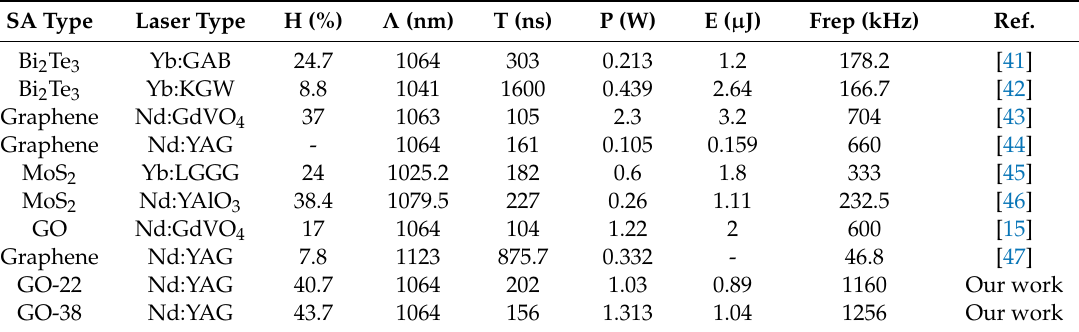
Figure 8. ( a ) Average output power of CW and QS as a function of the pump power; ( b ) repetition rates and pulse durations as a function of the pump power. Single pulse energy ( c ) and peak power ( d ) from passively Q-switched Nd:YAG laser versus incident pump power with GO-22 and GO-38 SAs. Table 1. Q-switched solid-state pulsed lasers based on